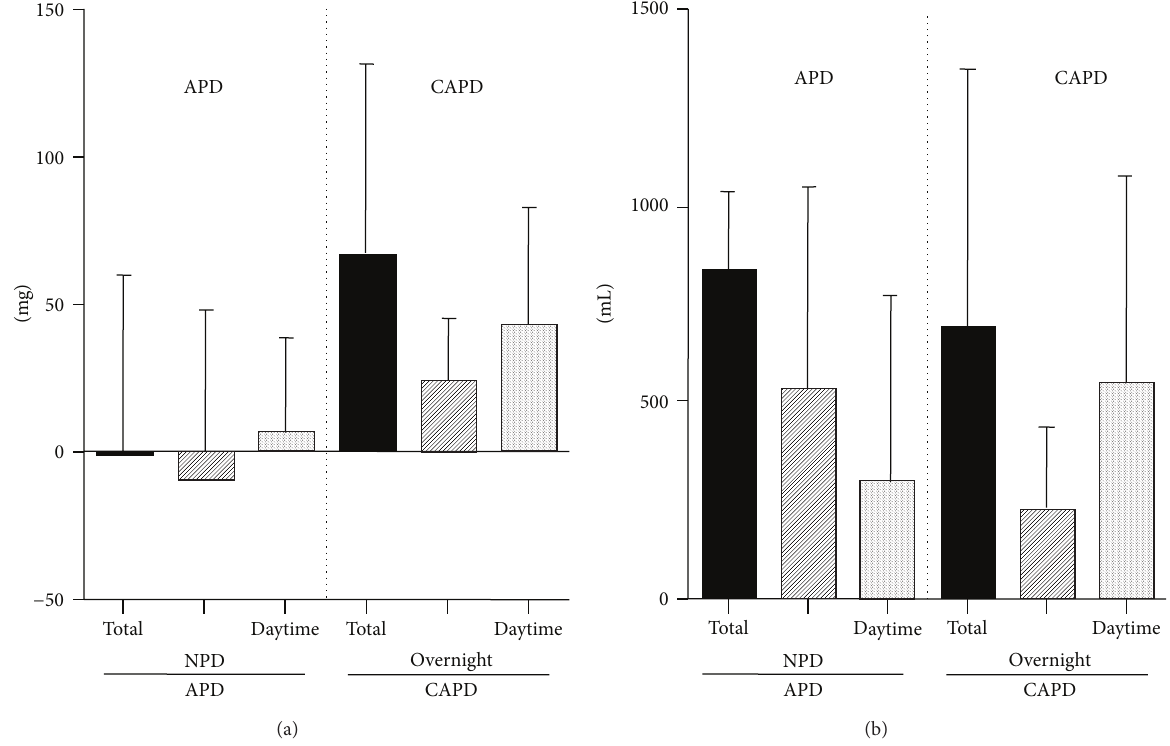
Figure 1: (a) Transperitoneal Ca balance and (b) ultrafiltration on APD and CAPD in same PD patients. Black bars show total Ca balance in 24 hours. Diagonal bars show transperitoneal Ca removal in NPD or overnight dwell. Dots bars show transperitoneal Ca removal in daytime